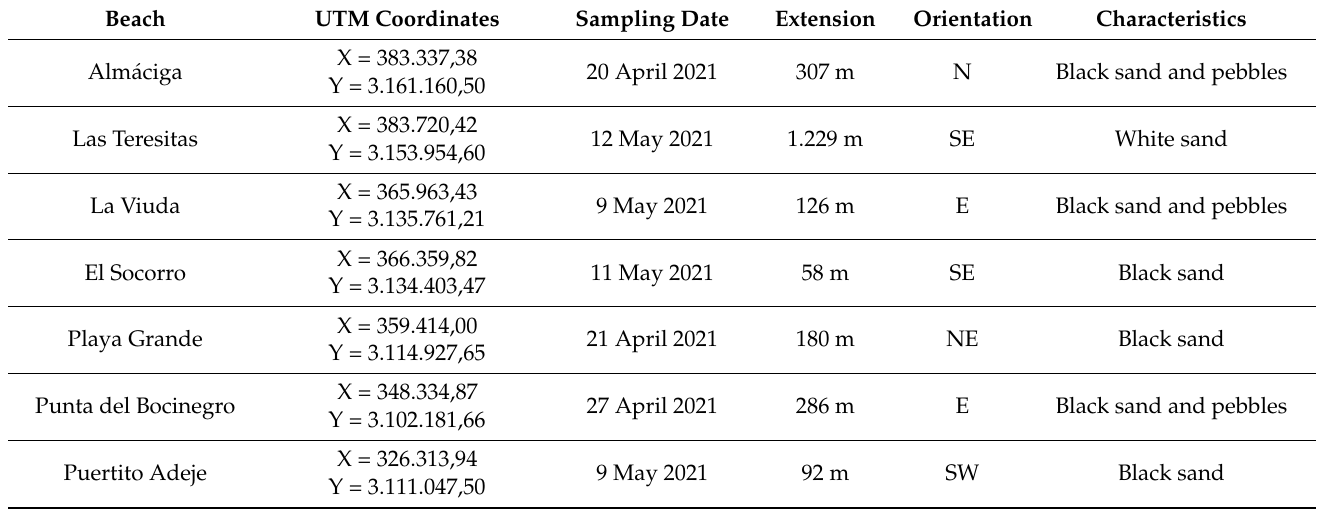
Table 1. Data on beaches locations and characteristics, as well as sampling